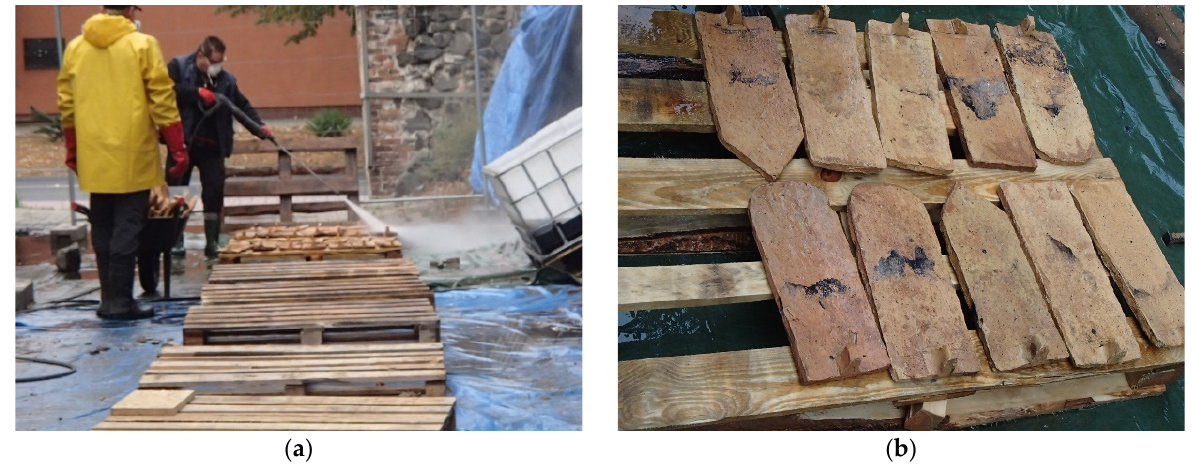
Figure 3. Revitalization of historic roof tiles: ( a ) cleaning; ( b ) maintenance.